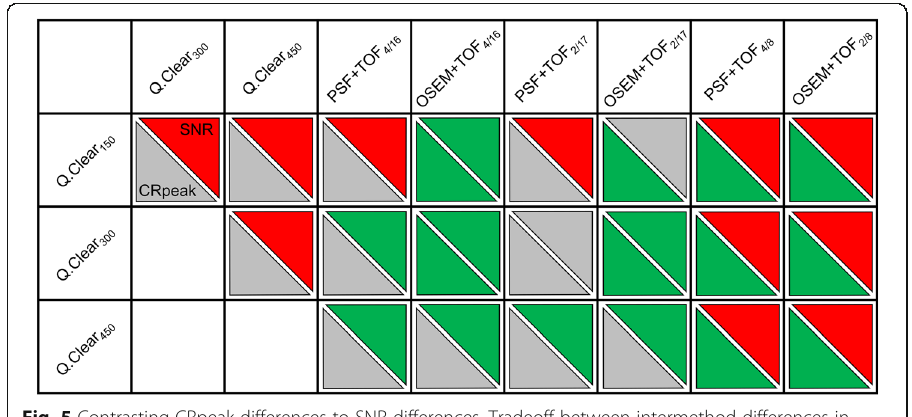
Fig. 5 Contrasting CRpeak differences to SNR differences. Tradeoff between intermethod differences in peak contrast recovery (CRpeak) and signal-to-noise ratio (SNR) is displayed for different pairs of reconstruction algorithms as a combined analysis of all SBR. Colors of the triangles represent either higher (green), equal (grey) or lower (red) CRpeak or SNR for the algorithm in the left column, respectively. For example, if in a certain pair of algorithms, one provides higher CRpeak for the small spheres at similar SNR (i.e., green and grey triangle) or vice versa, this algorithm may be attested superior overall image quality. For CRpeak, higher or lower values are defined as > 10% difference for at least one of the smaller spheres (10, 13, and 17 mm). For SNR, statistically significant differences (Wilcoxon test) are